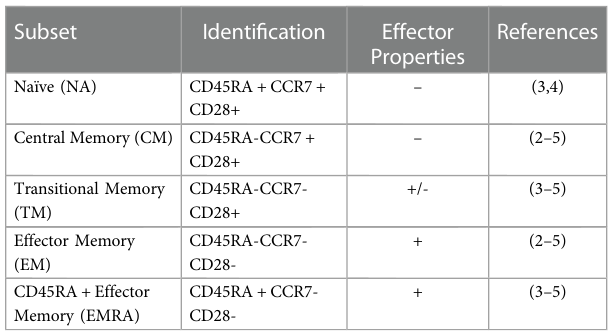
TABLE 2 Phenotypic identi fi cation of T cell subsets and functional properties.